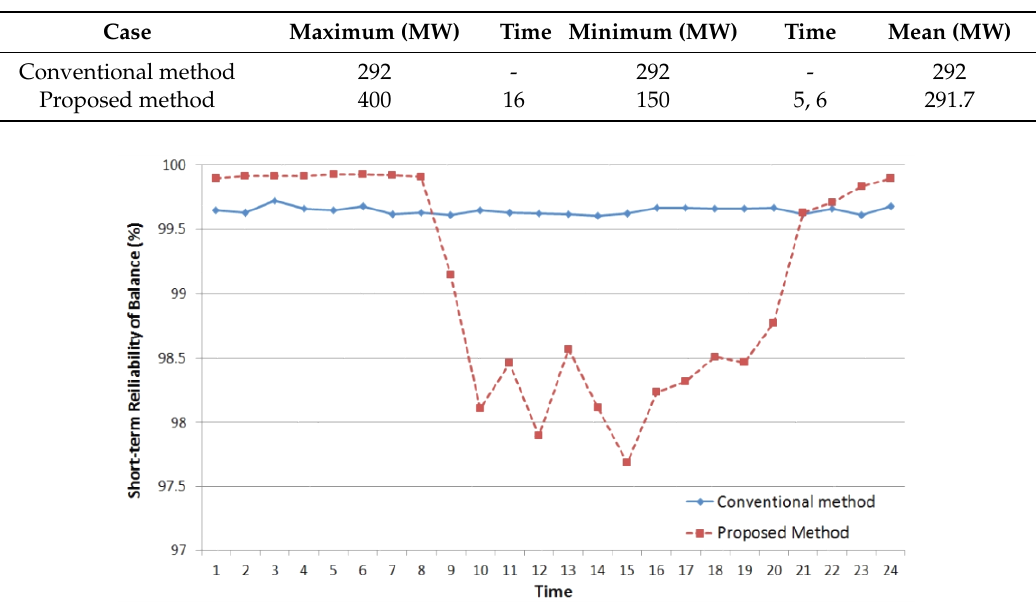
Figure 6. Hourly reliability based on the balance of supply and demand.